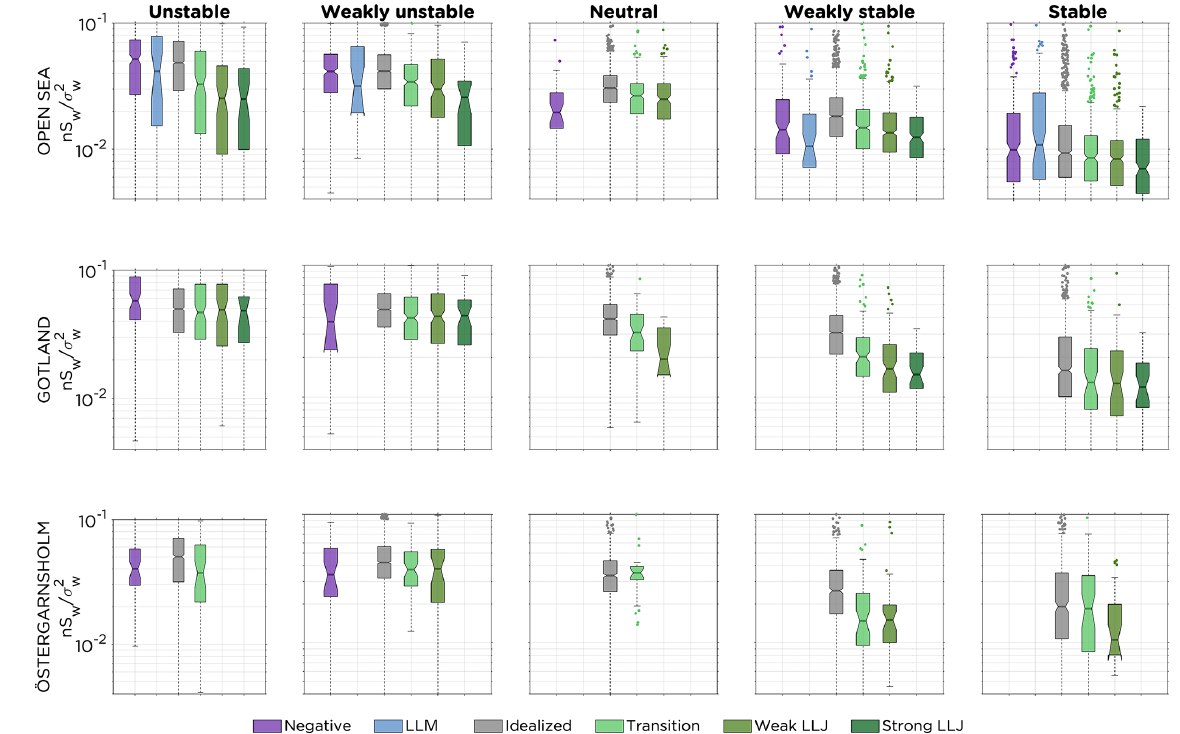
Figure 10. Distribution of normalized spectral values of w power spectra for the different wind profile classes for the selected normalized frequency of 0.01. The data are presented in the same manner as in Fig.